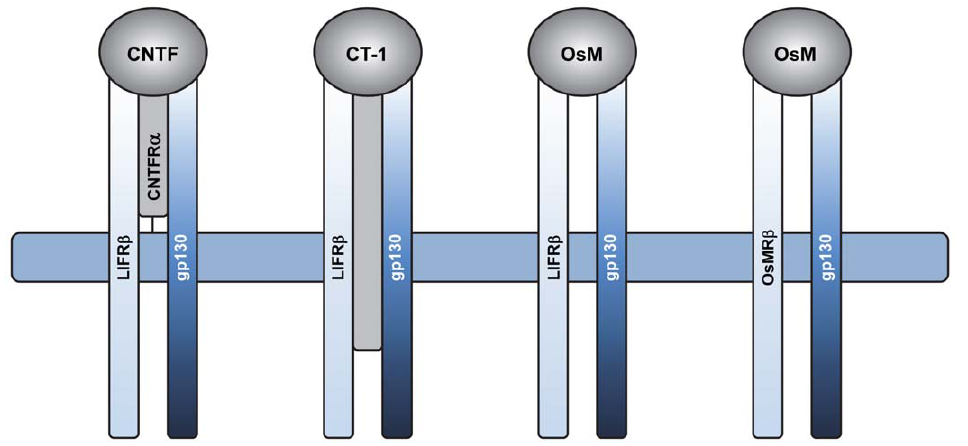
Figure 1. Schematic diagram of CNTF, CT1 and OsM cytokine receptor complexes. The cytokines are depicted schematically as grey circles. Signal transducing-receptor subunits are light blue (LIFR b and OsMR b ) or dark blue (gp130). a -receptor subunits are shown in light grey.